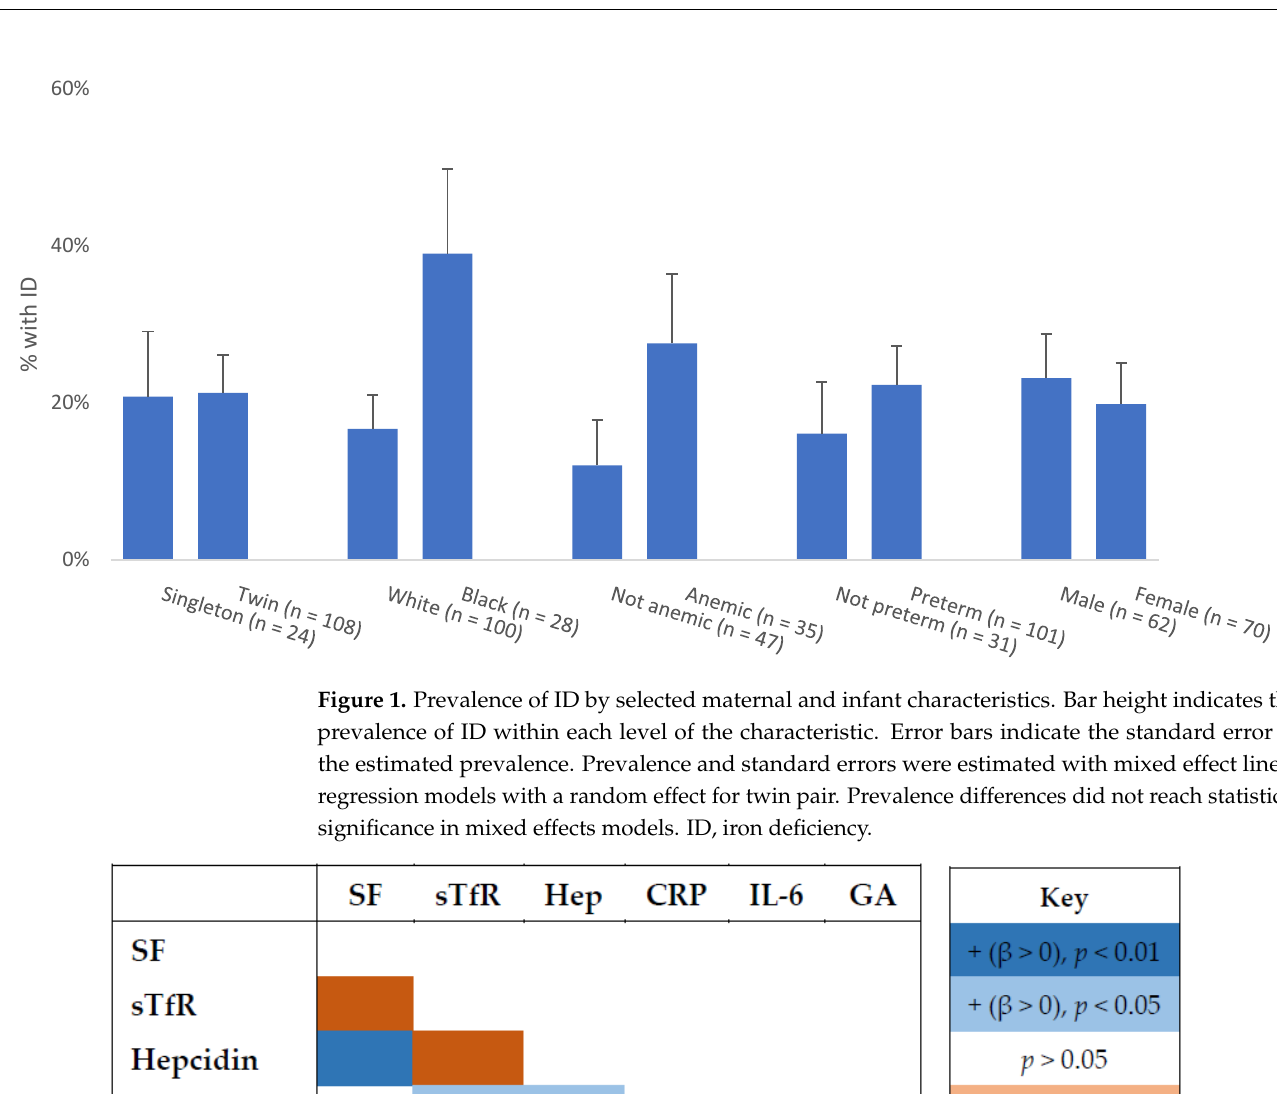
Figure 2. Associations among log-transformed iron and inflammation biomarkers, gestational age, and birth weight. Direction and strength of associations are indicated by color and intensity (see key). Values are from mixed effect models with random effects for twin pairs. n = 2 missing for IL-6. Abbreviations: BW, birthweight; CRP, c-reactive protein; GA, gestational age; IL-6, interleukin-6; SF, serum ferritin; sTfR, soluble transferrin